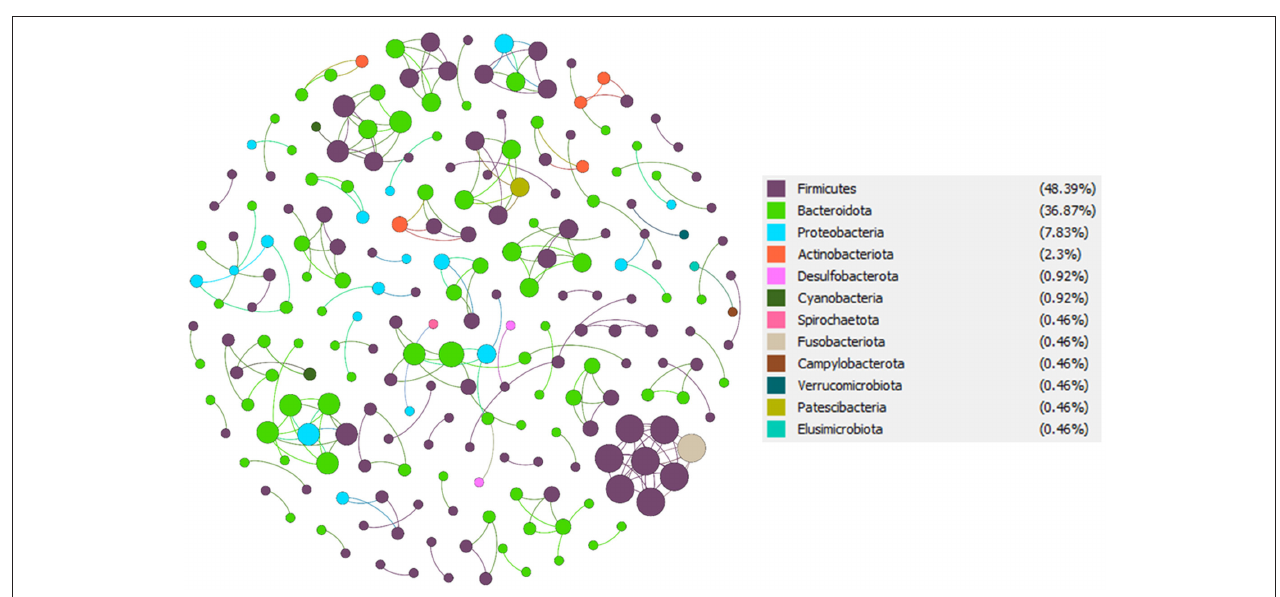
Frontiers in Microbiology |